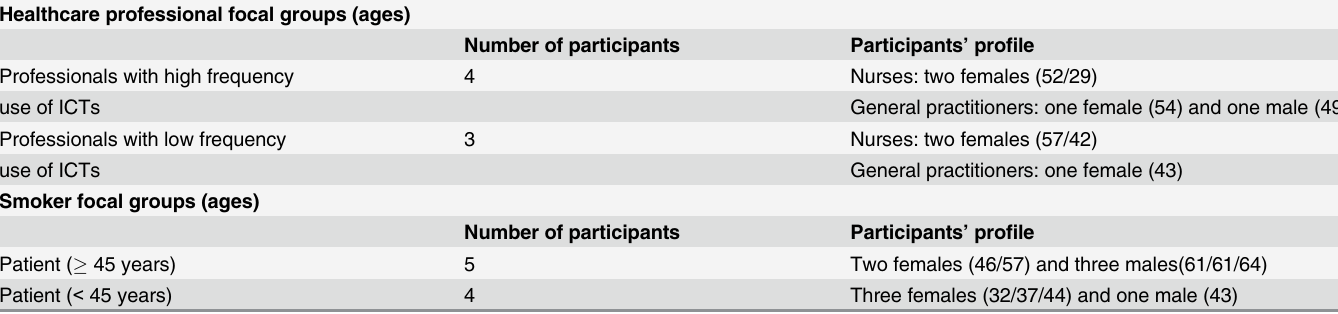
Table 2. Focal group